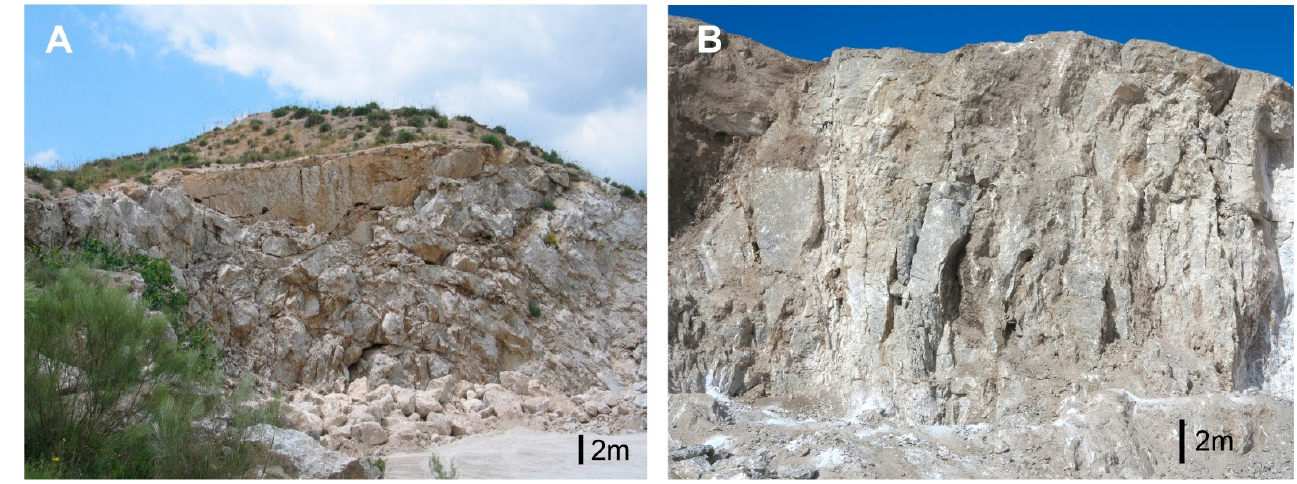
Figure 15. Old zones of the quarry where gypsum bank G2 outcrops: ( A ) fractured zone with a fault plane; ( B ) zone where numerous vertical fractures perpendicular to the stratification can be observed. These areas at depth may facilitate the passage of water and the accumulation of shale.